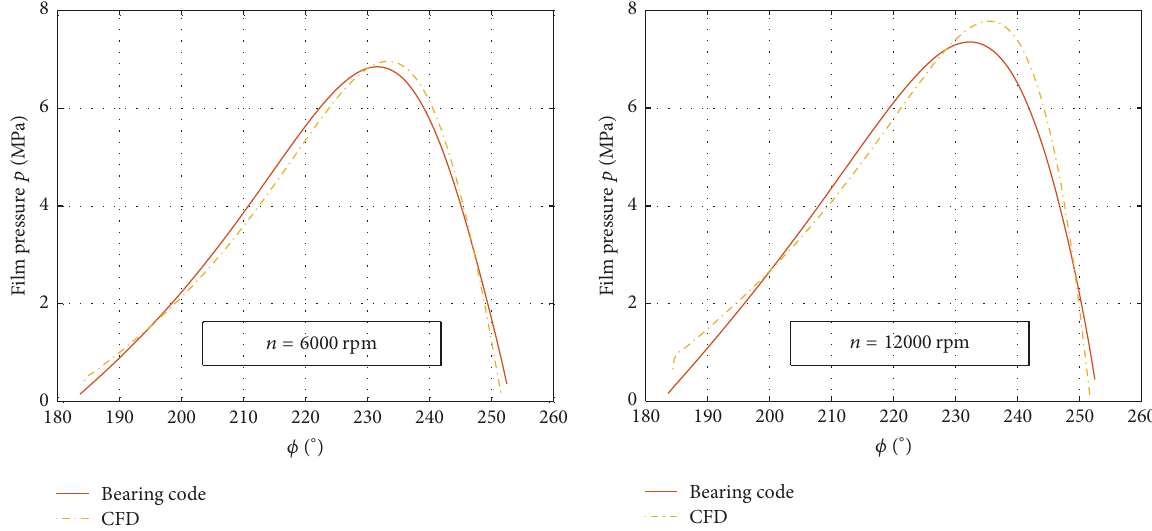
Figure 6: Comparison of predicted pressure distributions on pad 3 (TPB120, 𝑝 𝑞 = 2.0 MPa, 𝑄 = 90 l/min, 𝑇 sup = 50 ∘ C, 𝑧 = 36 mm).